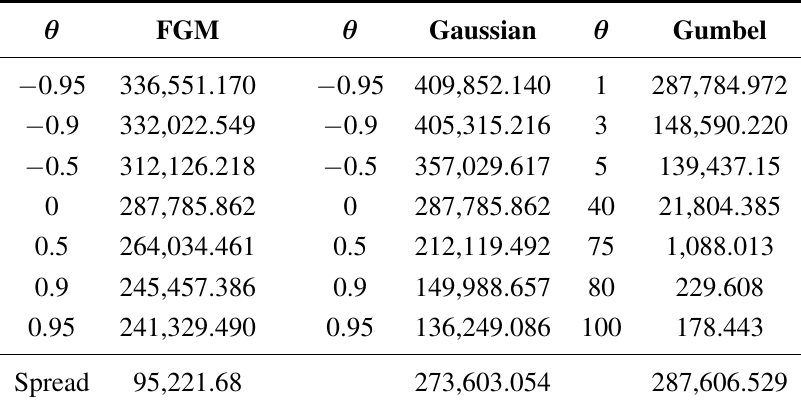
(5) for various copula. Z